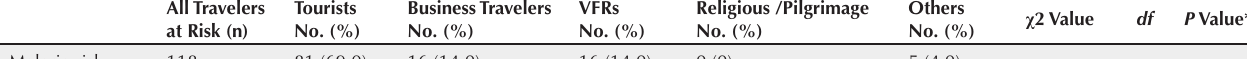
All Travelers Tourists Business Travelers at Risk (n) No. (%) No. (%)